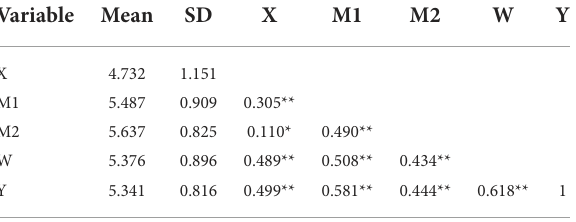
TABLE 4 Descriptive statistics and correlations of the